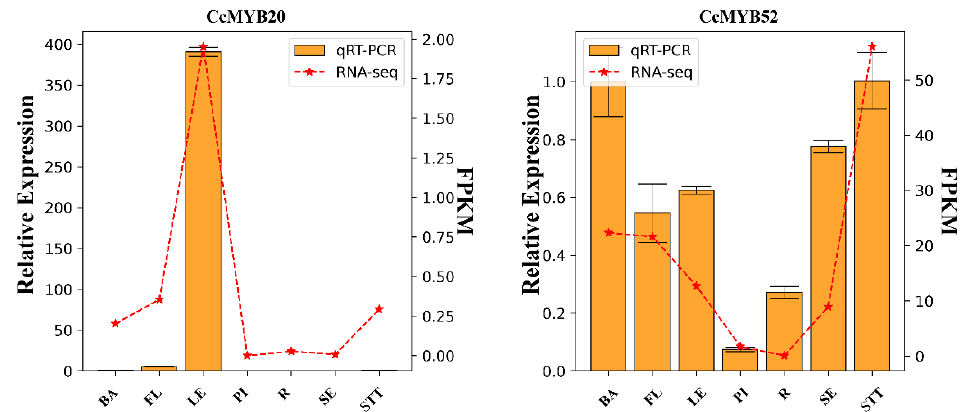
Figure 8. Expression validation of MYB genes related to flavonoid synthesis in different tissues and qRT-PCR and RNA-Seq results for four CcMYB genes in seven tissues of C. camphora . The abscissa represents seven tissues, in the following order: phloem (BA), flower (FL), leaf (LE), xylem (Pl), root (R), seed (SE), and stem (STT). The left ordinate represents the relative expression and the right ordinate represents FPKM. Orange bars: Expression data were normalized to CcActin gene expression levels, and the amount of expression in stems was normalized to “1”. Mean expression values were calculated from three replicates, and the vertical bars indicate the standard error of the mean. Red line graph: RNA-Seq expression results.